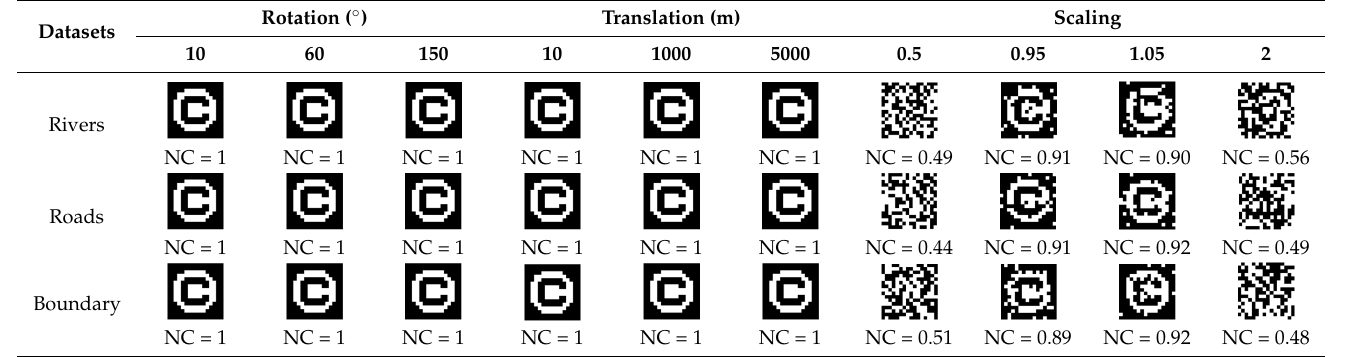
Figure 8. Overlay of original data and watermarked data. We choose rivers for instance.